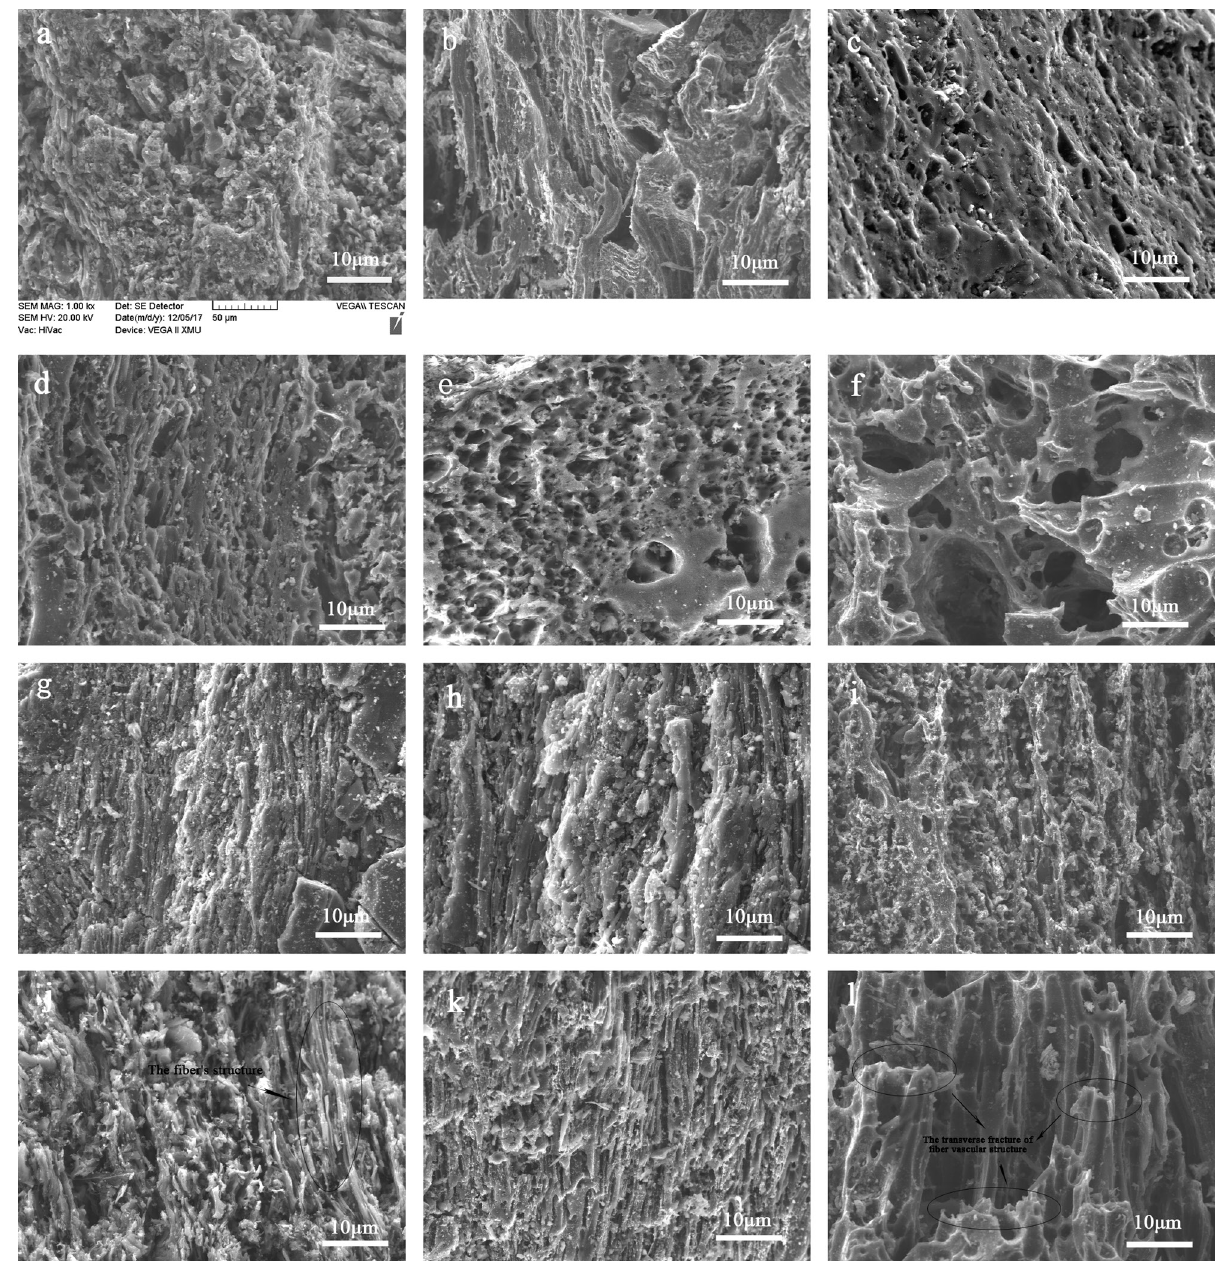
Figure 5: SEM images of BACs: (a,g) BAC-600, (b,h) BAC-700, (c,i) BAC-800, (d,g) BAC-900, (e,k) BAC-1000, (f,l)